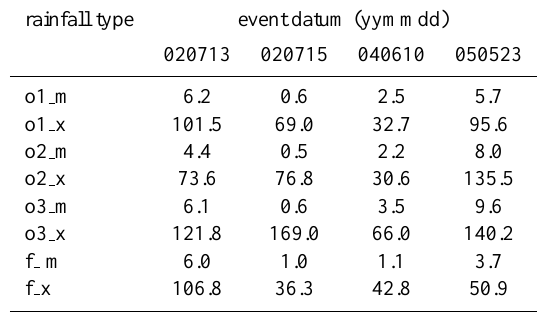
Characteristics of radar-based and forecast rainfall [mm] with accumulation of 6h (16:00UTC–22:00UTC). The mean (oX m) and maximum (oX x) observed values show grid rainfall values over the entire verification domain. X = 1, 2, 3 refers to the verification by using raw radar data, area corrected radar data and pixel-adjusted radar data, respectively. Similarly, f m and f x give the mean and maximum forecast